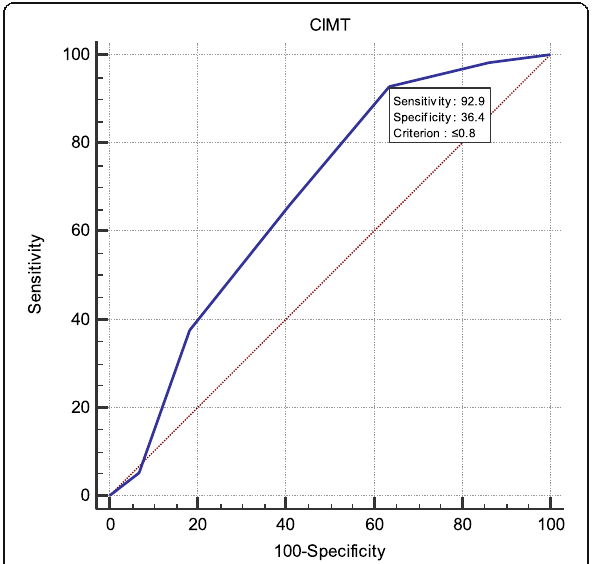
Fig. 3 High specificity of central SBP with PWV (97.6%)